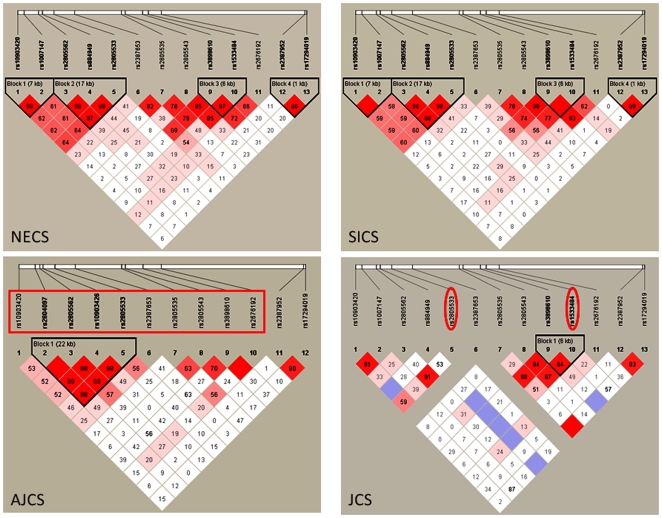
Pattern of LD among the SNP in ADARB2 (chromosome 10) that are associated with exceptional longevity.The four plots display the pattern of LD captured by the SNPs associated with exceptional longevity in ADARB2 (chromosome 10) in the NECS, SICS, AJCS and JCS data. The intensity of red cells represents the strength of LD measured by D′. The LD pattern in the NECS, SICS and AJCS subjects are very similar but differ substantially from the pattern of LD in the JCS subjects in which two SNPs become almost monomorphic (rs884949 and rs2387653). Highlighted in red are the SNPs that replicate the results in the AJCS and JCS subjects.